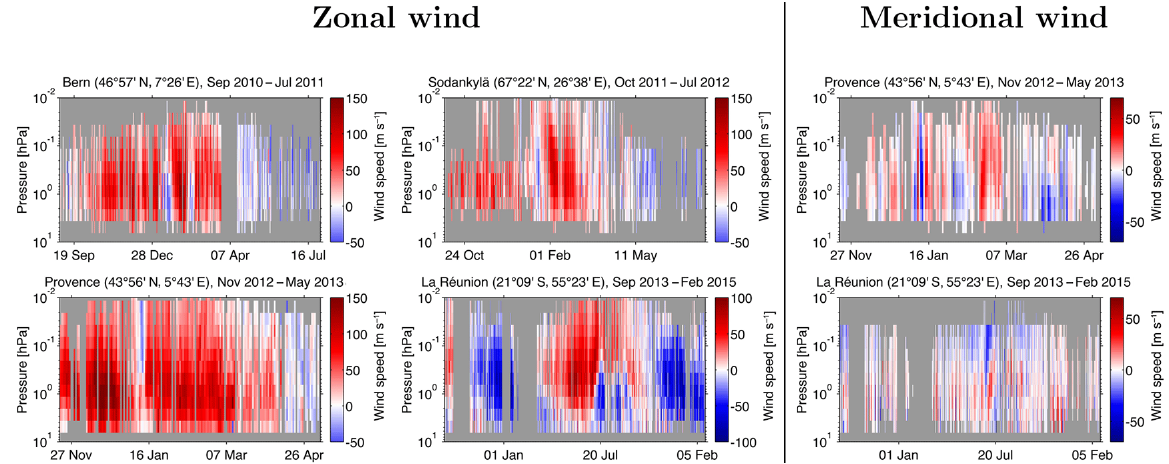
Figure 1. The zonal and meridional wind time series measured by WIRA during four different measurement campaigns analyzed in the present study. The gray areas correspond to data points judged untrustworthy according to the conditions indicated in the text. Please note the different color scale for zonal and meridional